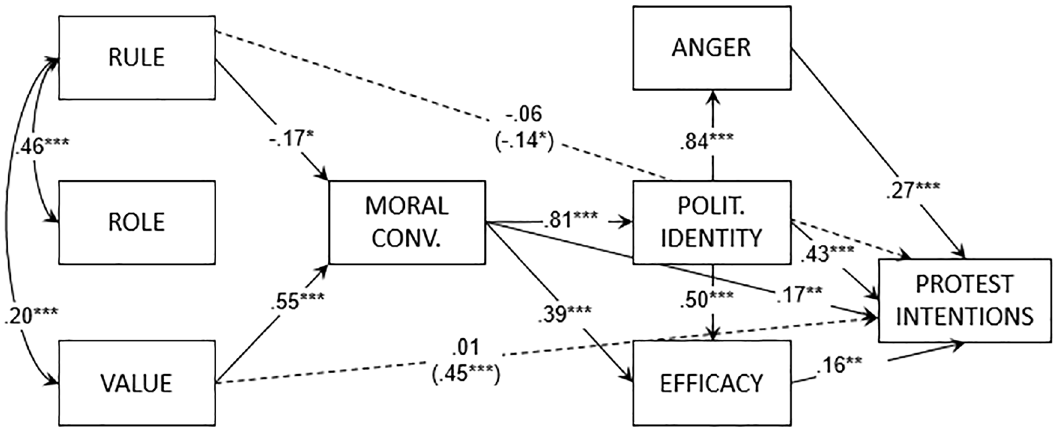
Figure 3. Path model of Study 2 (human rights-protecting protest group). Note . Reported coefficients are standardized. In parentheses, the indirect effects from the orientations to protest intentions. Polit. =